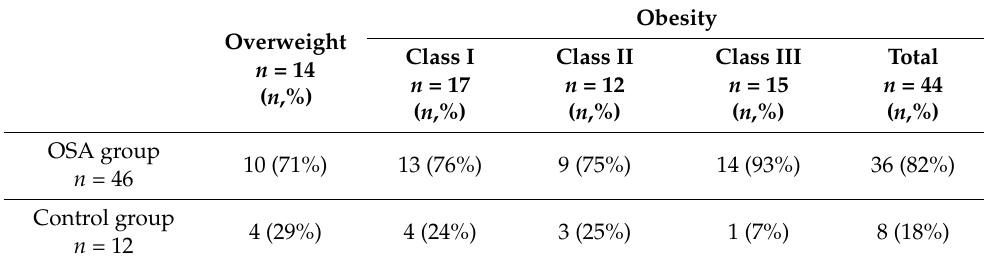
Table 2. Occurrence of obstructive sleep apnea in patients with obesity or overweight.